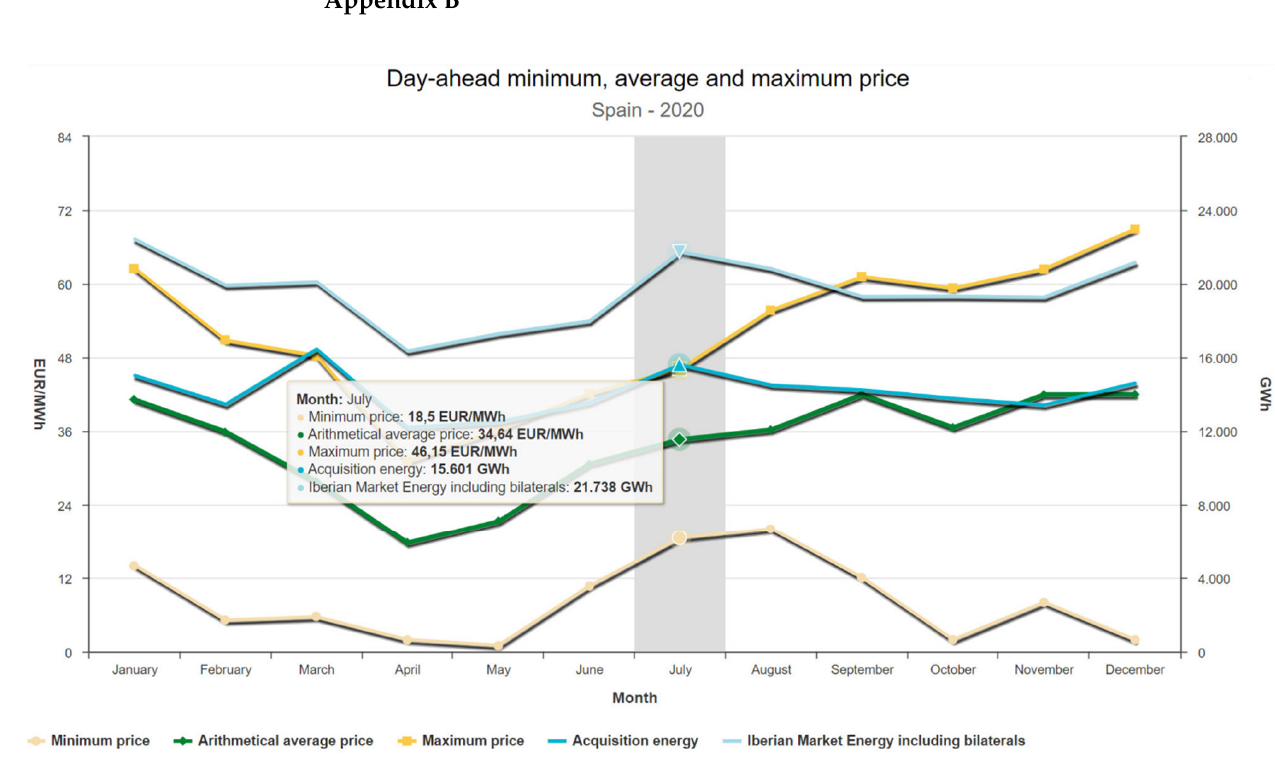
Figure A1. Average price used for some of the KPI S to quantify the benefits (source: OMIEData).